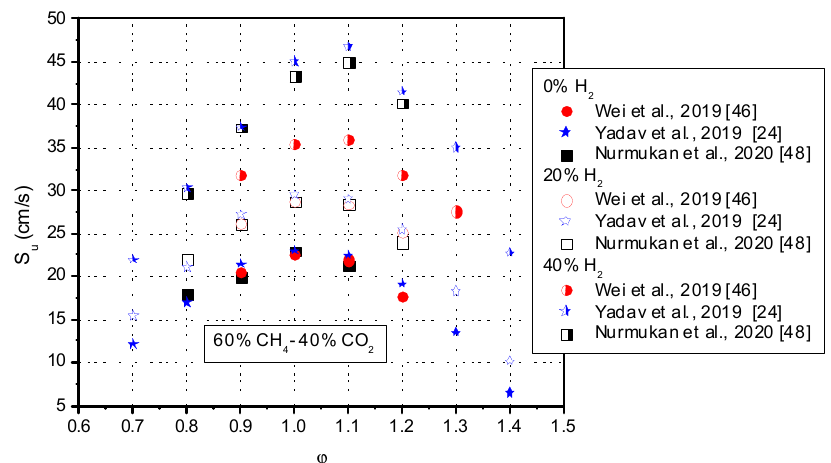
Figure 12. Variation of the experimental laminar burning velocities of H 2 -enriched biogas mixtures at various equivalence ratios and standard initial conditions; Biogas composition: 60% CH 4 –40% CO 2 .